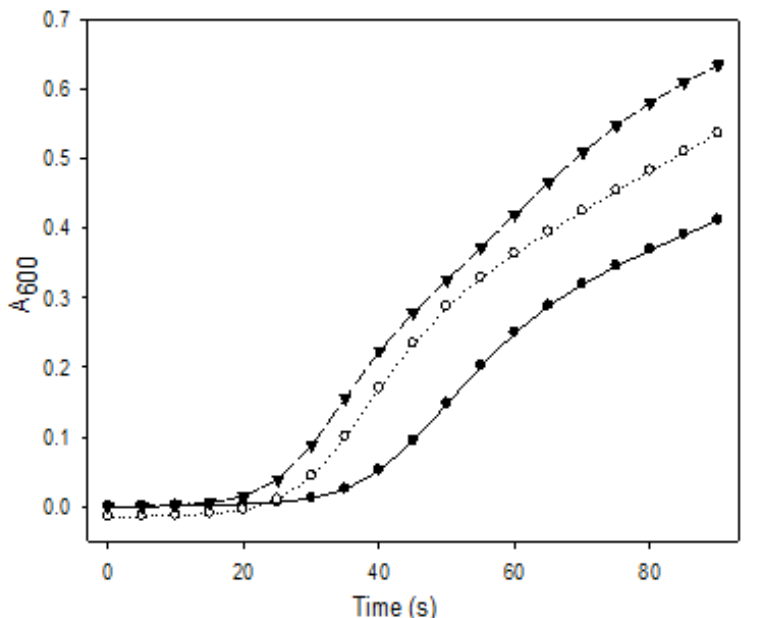
Figure 8. CO 2 sequestration in CaCO 3 . Solid circle: negative control without the addition of enzyme; open circle: reaction catalyzed by R5-SazCA-SP; solid triangle: reaction catalyzed by R5-SazCA. The formation of CaCO 3 was monitored turbidometrically at A 600 .